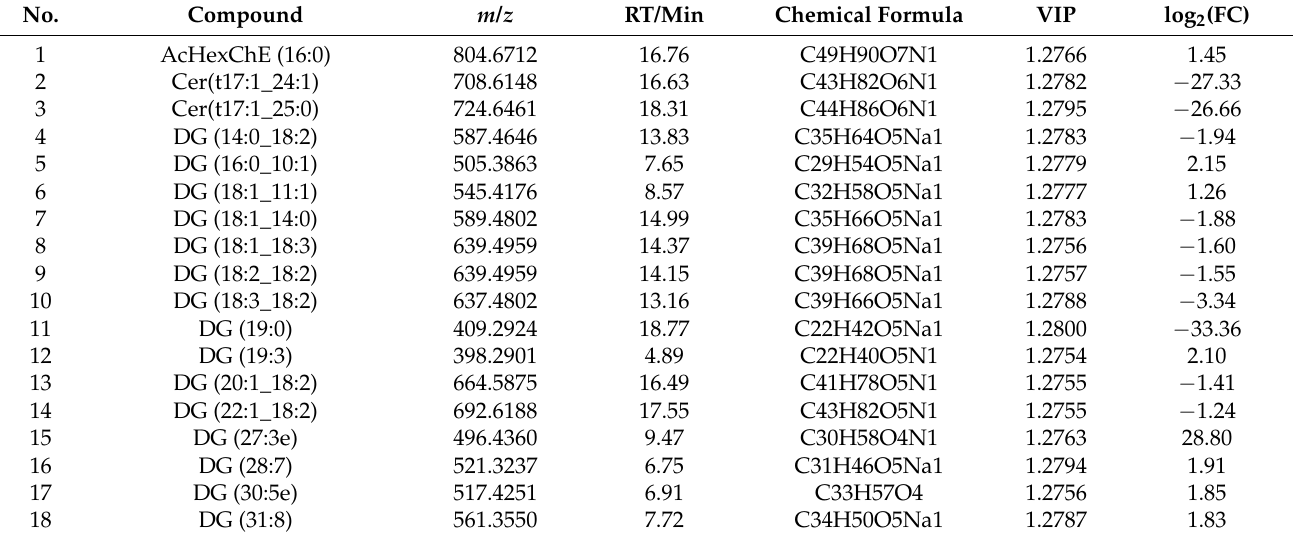
Table 9. Statistical table of specific differential lipids in